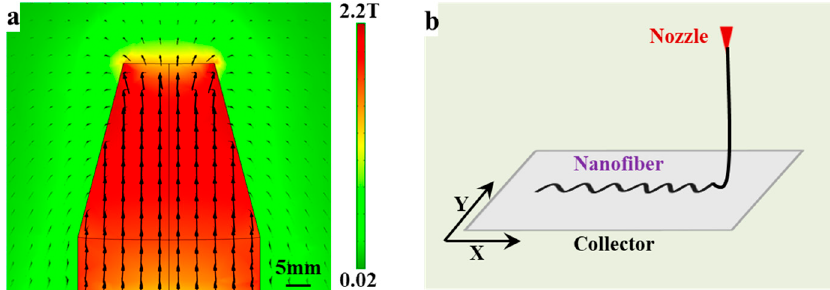
Figure 10. ( a ) Magnetic spinning device. ( b ) Magnetic spinning simulation diagram.